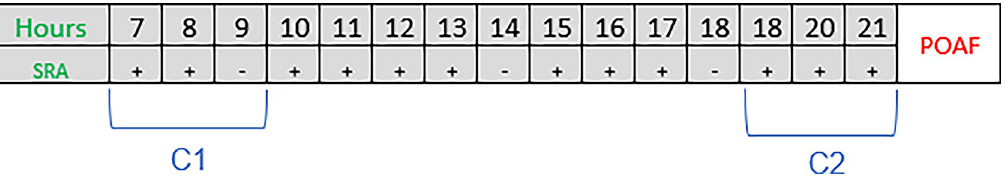
Fig 3. Example of a patient with POAF at 9 pm on the first postoperative day. Again, the predominance of positive results that characterize the patient at risk for